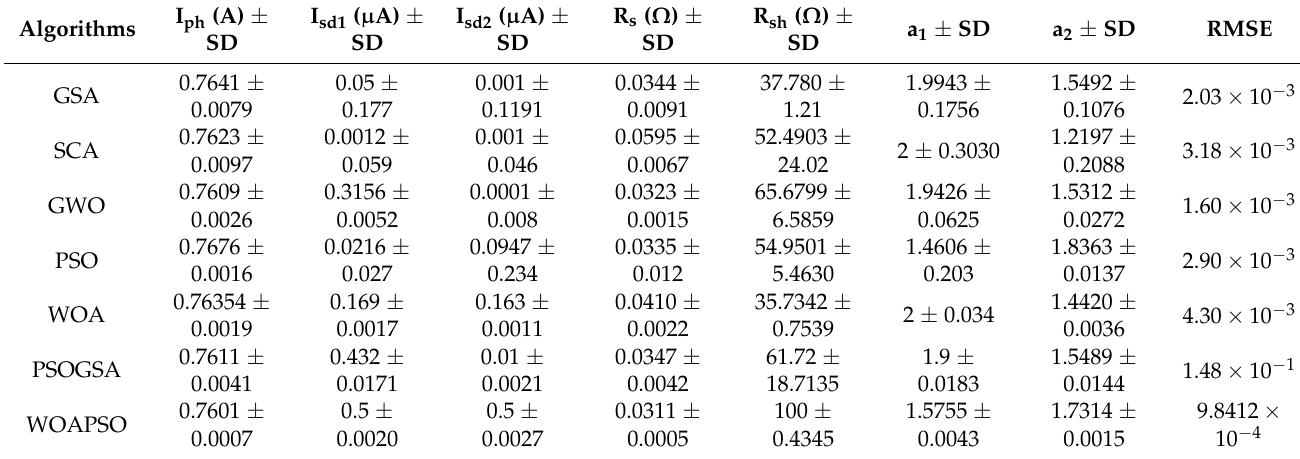
Table 3. Comparison of WOAPSO with different parameter estimation methods for